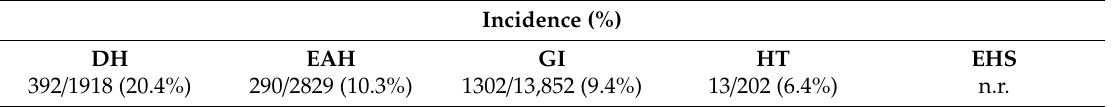
Table 4. Incidence of adverse outcomes in endurance / ultra-endurance sports in cohort studies. Incidence (%) DH EAH GI HT EHS 392 / 1918 (20.4%) 290 / 2829 (10.3%) 1302 / 13,852 (9.4%) 13 / 202 (6.4%)